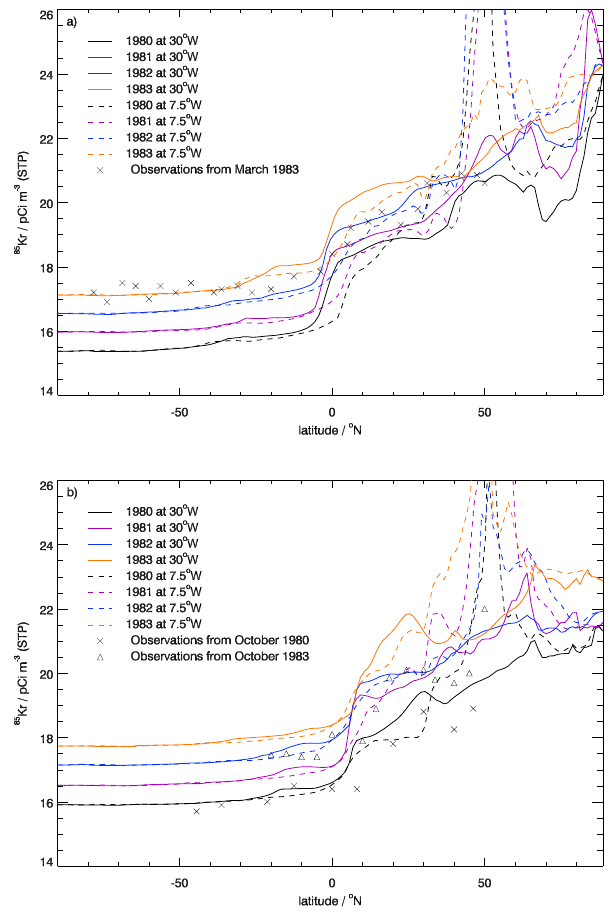
Fig. 10. Comparison between observed meridional profiles of 85 Kr concentrations with modelled concentrations from UKCA over the Atlantic ocean (a) in March and (b) in October. Observations are taken from Weiss et al. (1983) and UKCA was sampled at two lon- gitudes (7.5 and 30 ◦ W) to straddle the area sampled by the obser-